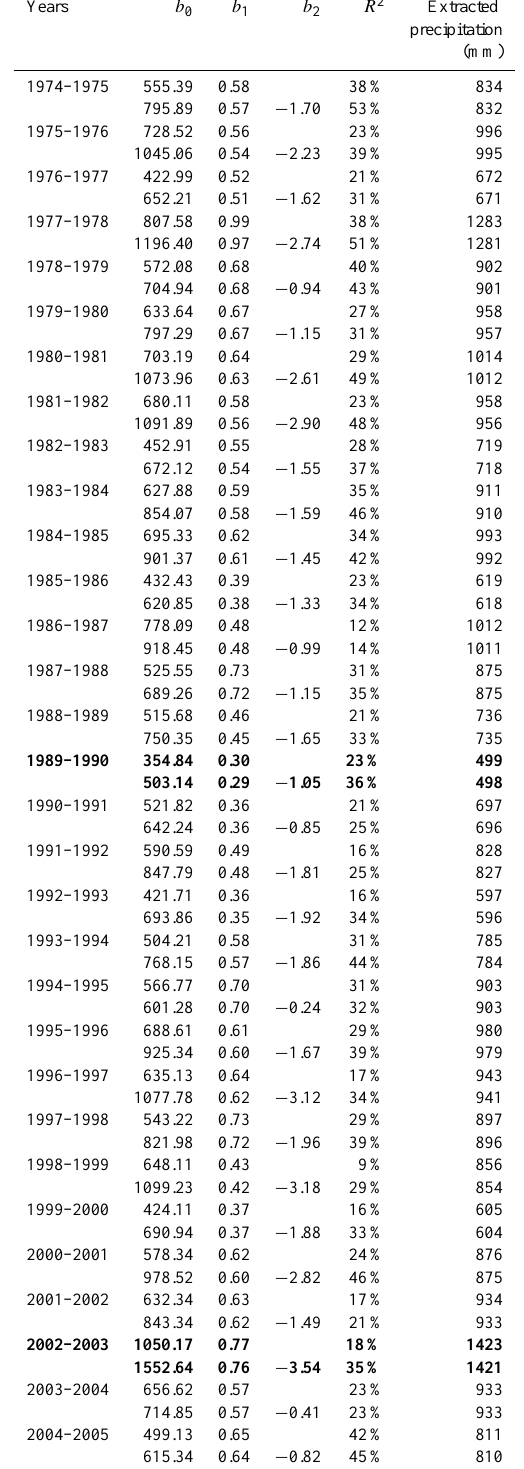
Table 2. Simple and two-variable linear regression for 55 stations, regarding each year of 1974–2005. The years 1989–1990 and 2002– 2003 are in bold as years with the minimum and maximum precipi- tation amount,